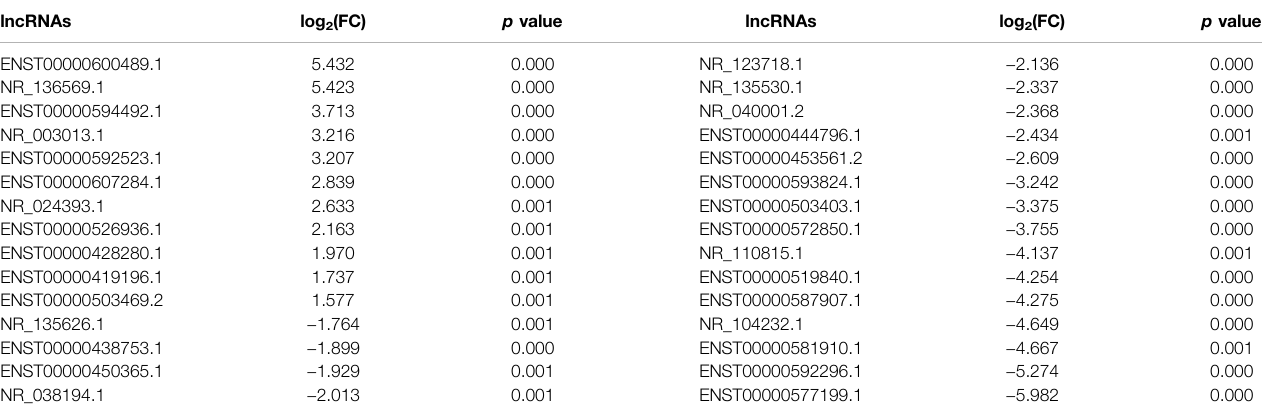
TABLE 1 | DE lncRNAs in the neutrophil exosomes of DM patients (Top 30). lncRNAs log 2